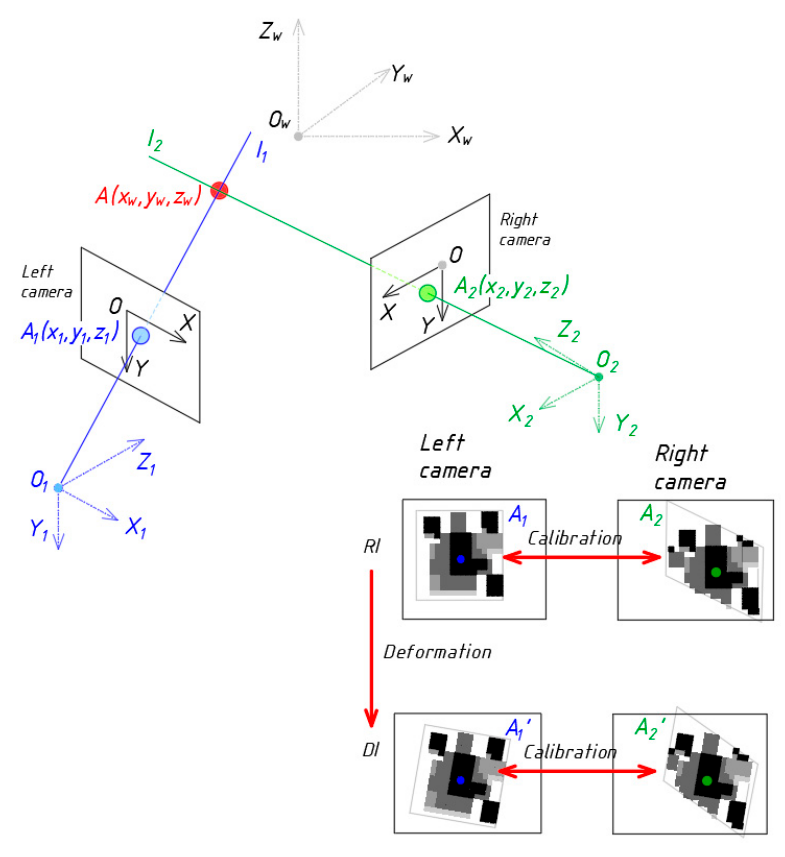
Figure 6. Scheme of measurement procedure and comparison of data when using 3D-DIC.